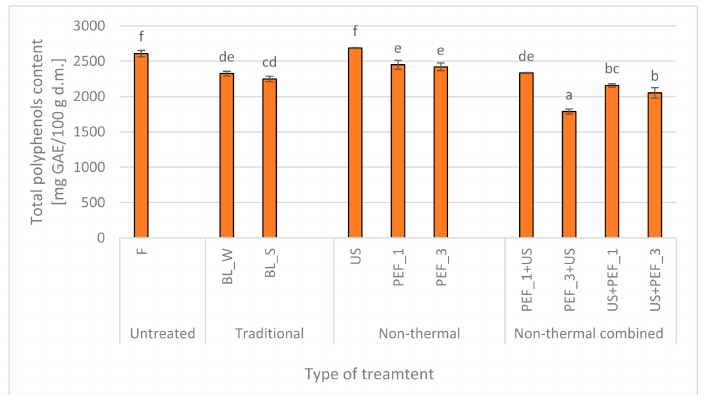
Figure 3. Total polyphenols content in fresh (F) red bell peppers and subjected to traditional (blanching in water, BL_W and blanching in steam, BL_S) and non-thermal single treatment (US—ultrasound, PEF_1 and PEF_3—pulsed electric field with energy input 1 and 3 kJ / kg, respectively) and combined treatment (PEF + US and US + PEF), the same letters indicate homogeneous groups (Tukey’s HSD, p < 0.05), the error bars represent the standard deviation calculated from 3